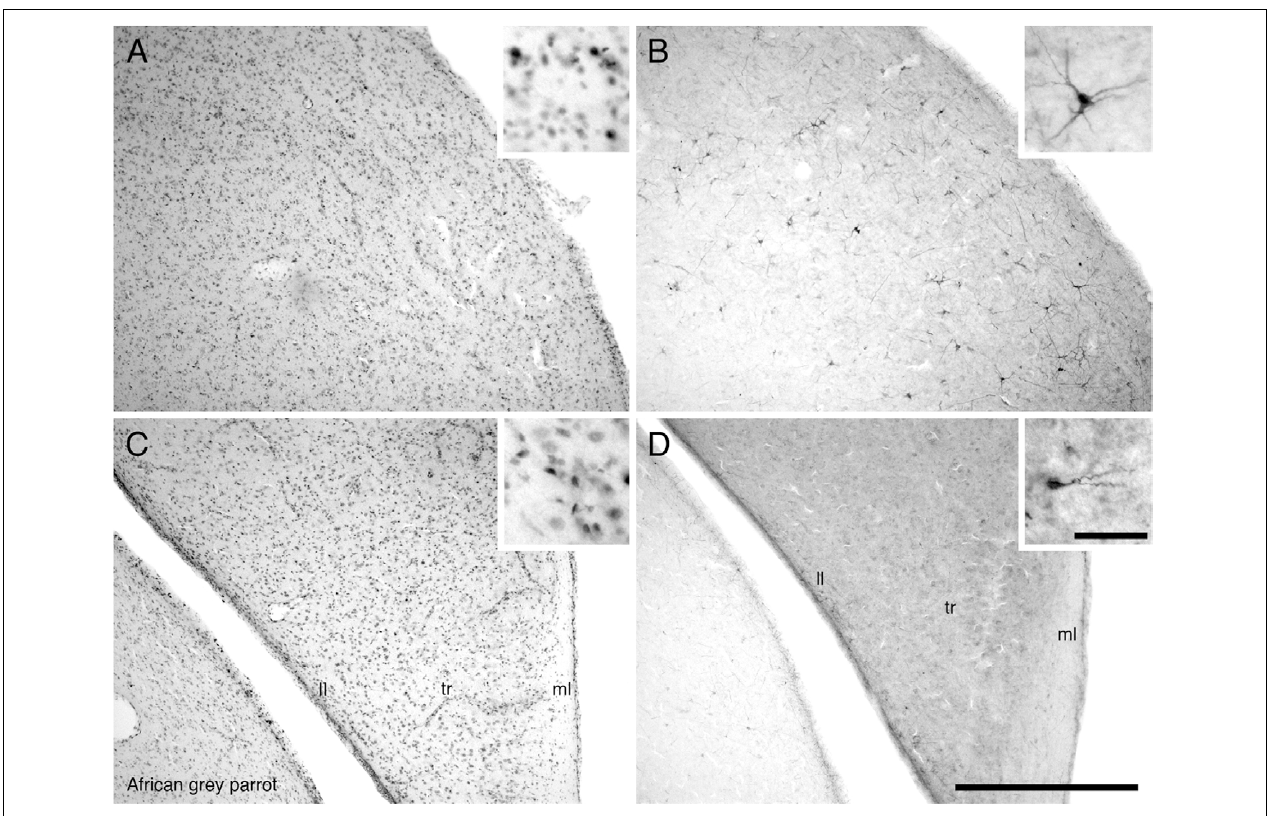
FIGURE 5 | Photomicrographs of PCNA – (A,C) and DCX (B,D) – immunostained coronal sections through the hippocampus (HP) in the brain of the African grey parrot ( Psittacus erithacus ). Distribution of PCNA immunoreactive cells in the dorsal hippocampus (A) , and ventral layers of the hippocampus (C) . Insets in (A,C) show a higher magnification images of PCNA immunoreactive cells. Distribution of DCX immunoreactive cells in the dorsal hippocampus (B) , and ventral layers of the hippocampus (D) . Insets in (B,D) show a higher magnification of DCX immunoreactive cells. All high power images on inserts were taken from consecutive sections to low power images. Note multipolar DCX immunoreactive cells in (B) compared to unipolar DCX immunoreactive cells in (D) . In all images dorsal is to the top and medial to the right. Scale bar in (D) = 500 µ m and applies to (A–D) . The scale bar in the inset in (D) = 50 µ m and applies to all insets. See list for